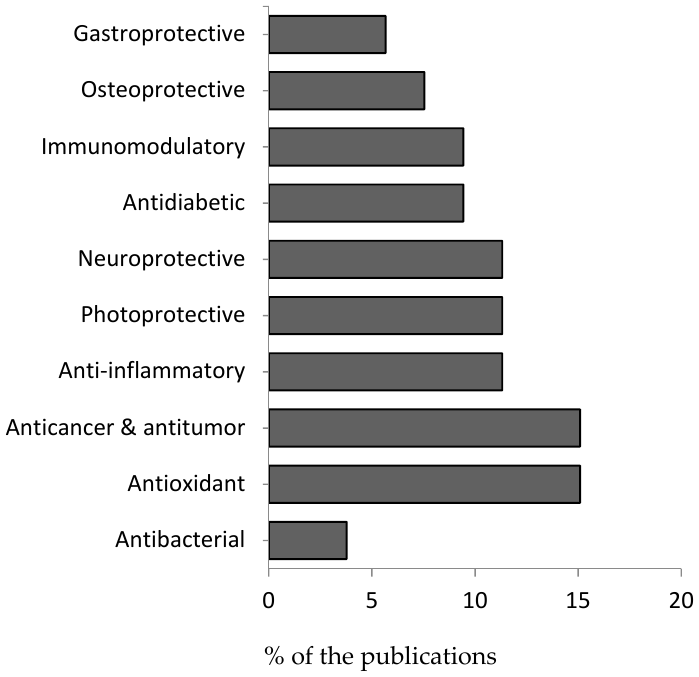
Figure 2. The number of publications related to the nutritional and pharmacological properties of H. fusiformis.